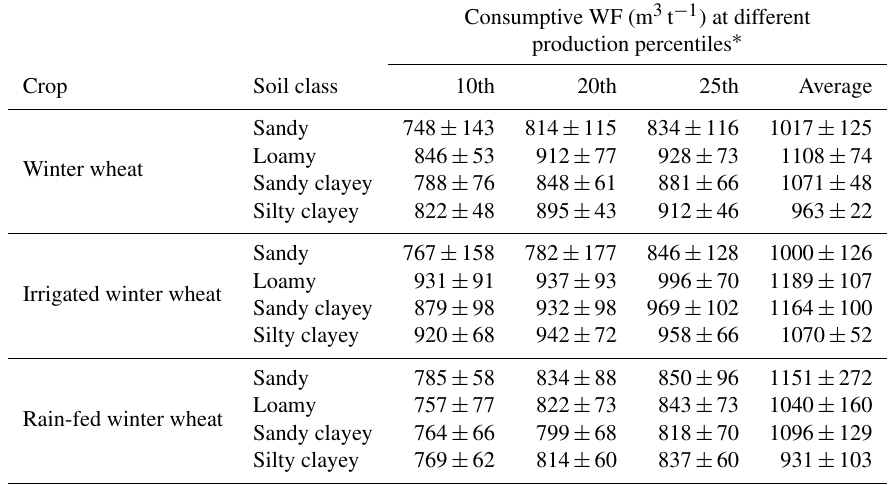
Table 5. Benchmark levels for the consumptive water footprint (WF) (m 3 t − 1 ) of winter wheat for different soil classes in China.